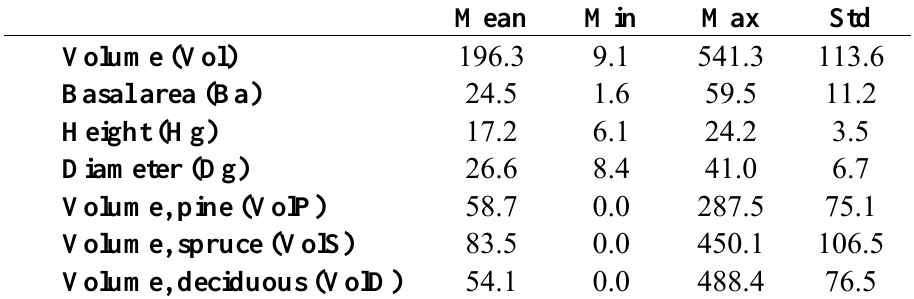
Table 1. Mean, range and standard deviation of the stand characteristics (n =